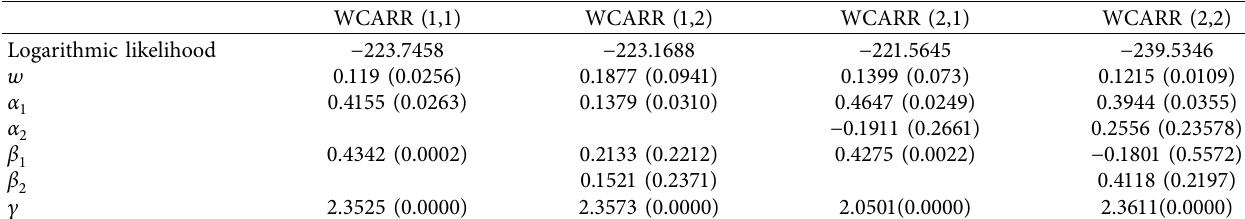
Table 4: Comparison of different lag order estimation results of the WCARR model based on B segment Dow Jones weekly data.